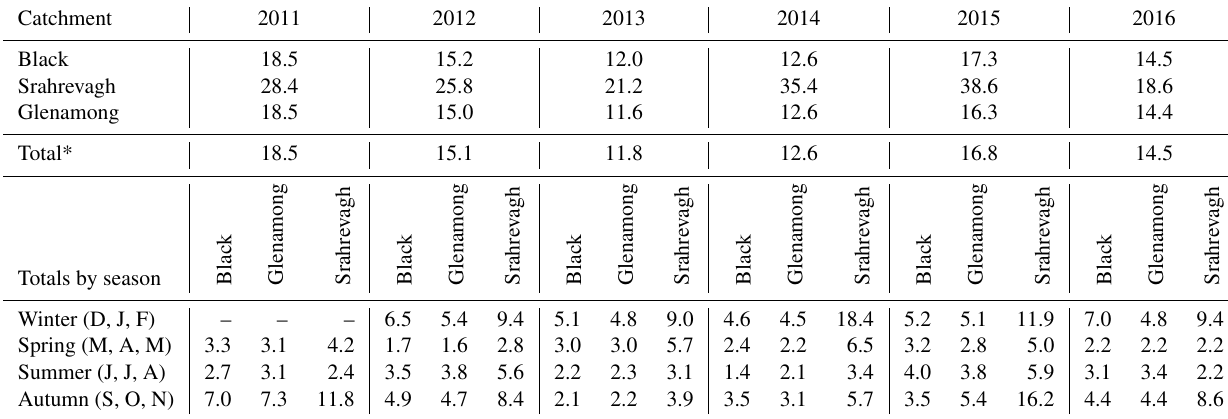
Table 3. Estimated DOC load (tCkm 2 yr − 1 ) from the Black, Srahrevagh and Glenamong catchments between 2011 and 2016. Seasonal loads are linked to the years in the table header. Winter (D, J, F) stands for December, January, February, etc.